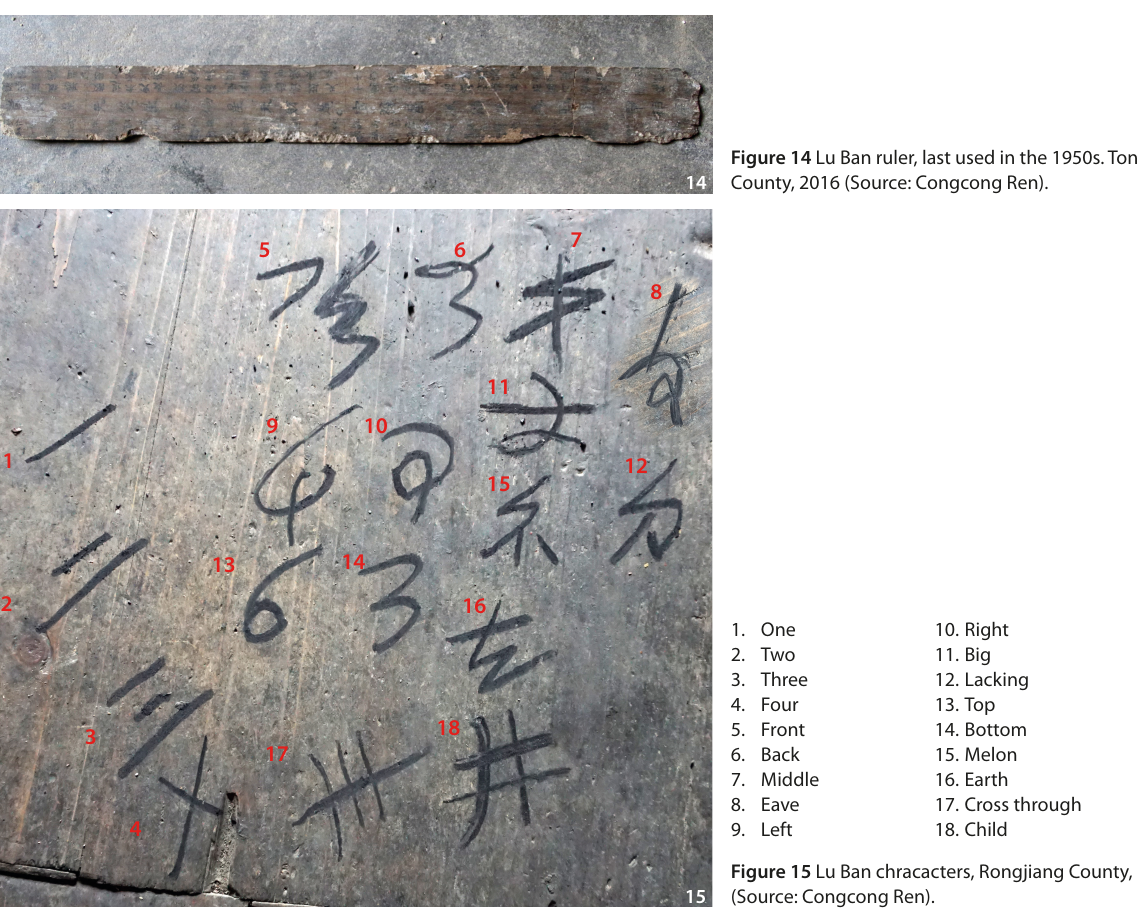
Figure 15 Lu Ban chracacters, Rongjiang County, 2017 (Source: Congcong